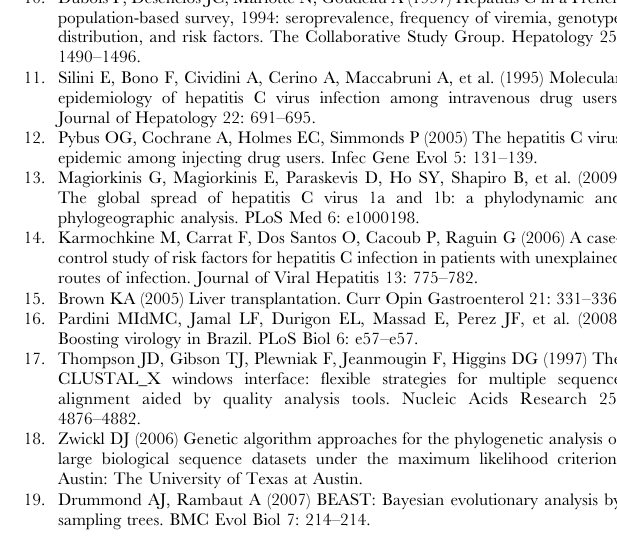
colors as in Figures 2 and 3) versus the log of the human population size at the time of the most recent common ancestor (TMRCA) of the subtype. Found at: doi:10.1371/journal.pone.0011170.s004 (0.52 MB TIF) Figure S4 Higher human population growth correlates with higher rates of HCV growth. (A) Census population growth in Sa˜o Paulo (red dots) and the UK (blue dots) during the 20th Century. The best-fit curve for both populations indicate linear growth in the UK and exponential growth in the State of Sa˜o Paulo. (B) By partitioning the population of Brazil and the UK into age groups, it appears that most of the growth in Brazil is taking place among the age group that we found to be at a higher risk of infection by HCV-1a and 3a (20–39 years-old). (C) The population growth rate of HCV- 1a and HCV-3a was consistently higher in Brazil than in the UK, suggesting that human population growth accelerates HCV